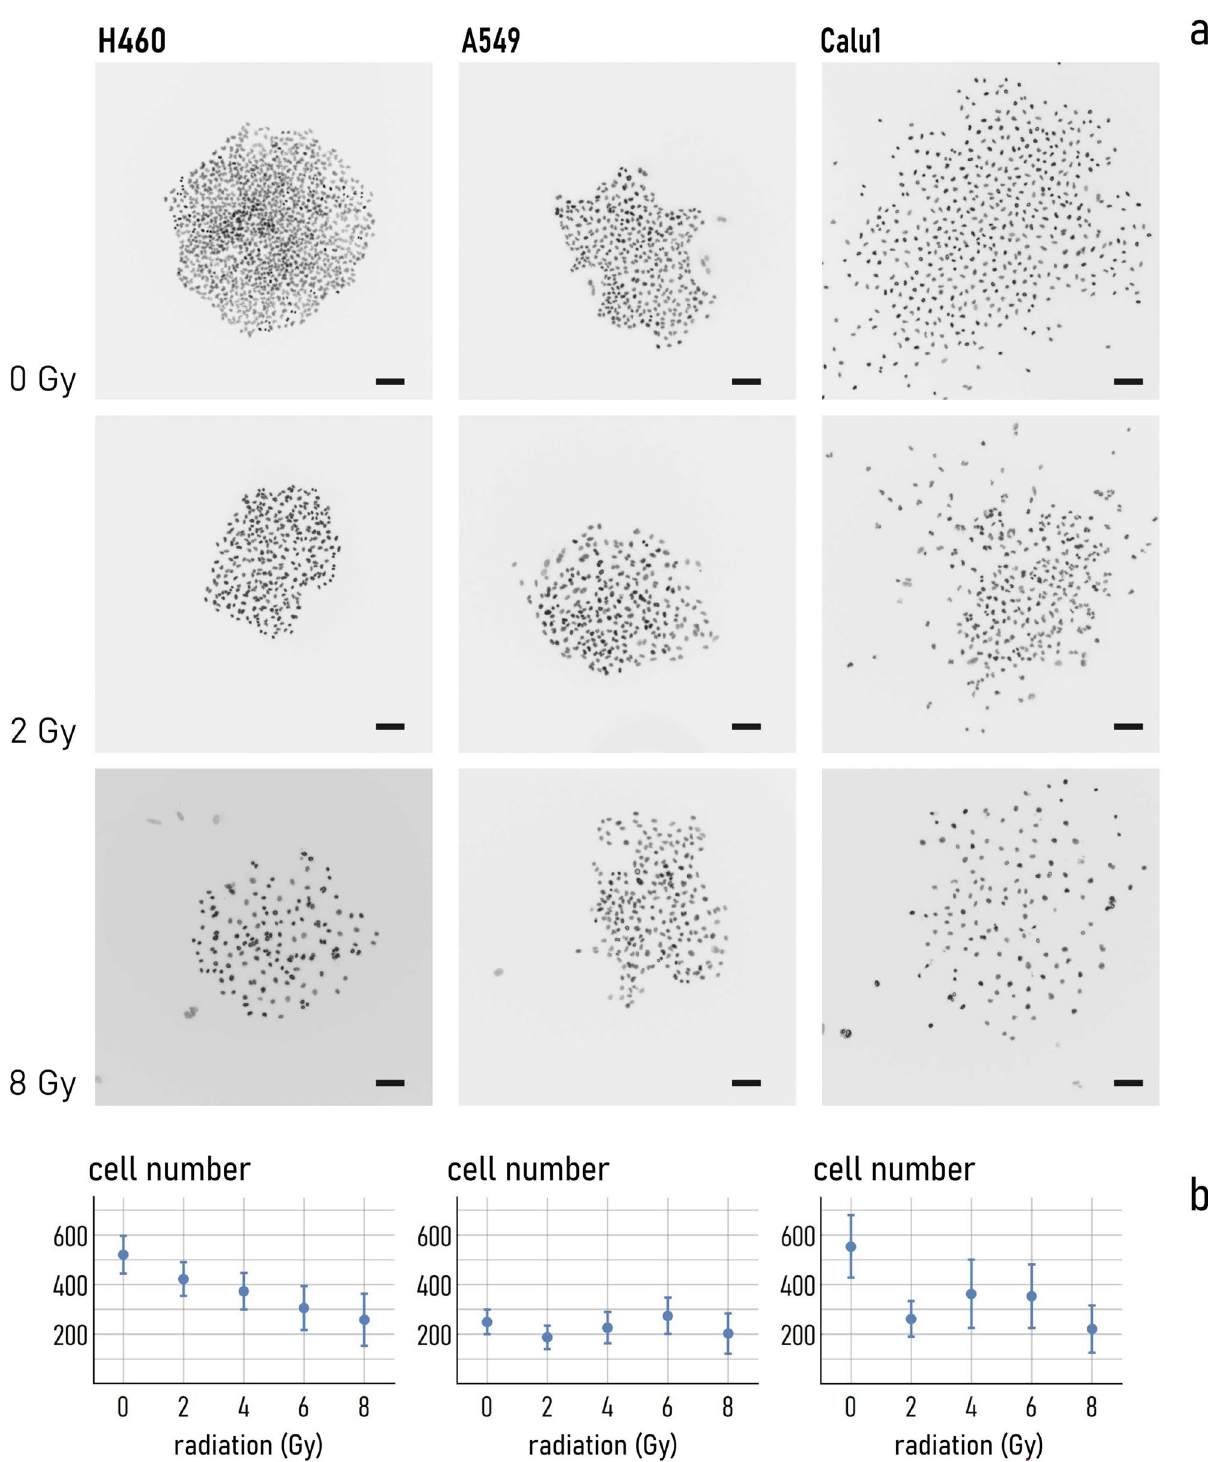
Figure 2. Representative fluorescent images of H460, A549 and Calu-1 cells taken with a 10X objective at 0 Gy and at different values of the irradiation dose: 2, 8 Gy ( a ). Number of H460, A549 and Calu-1 cells on the substrate evaluated at different levels of the dose ( b ). For all images the scale bar is 100